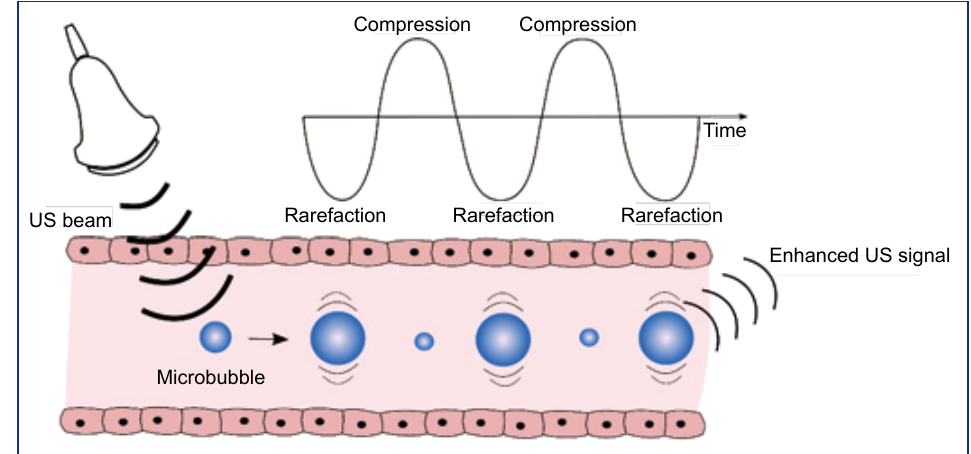
Figure 1 Low mechanical index (MI) ultrasound waves elicit non-linear rarefaction and compression of the microbubbles leading to enhancement of the ultrasound signals reflected by the microbubbles compared with the surrounding tissues.